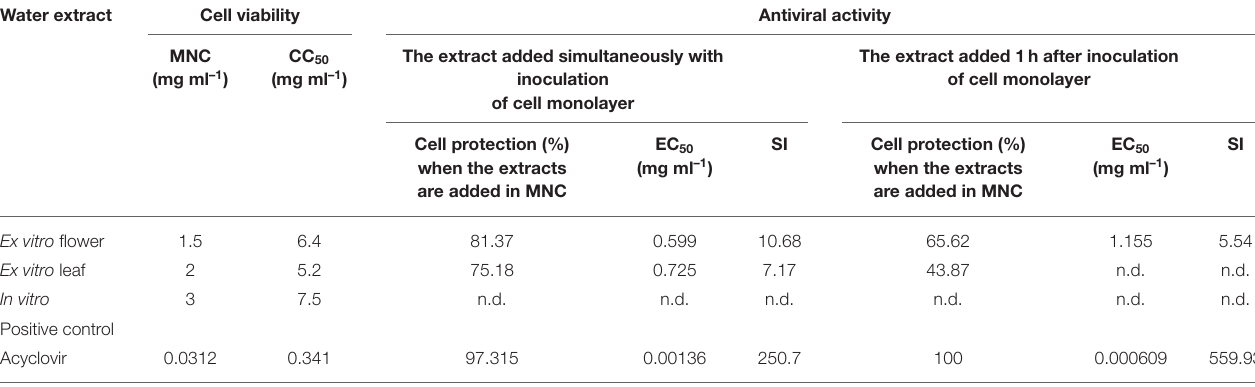
TABLE 2 | Antiviral activity of N. nuda water extracts against HHV-1 (strain F). Water extract